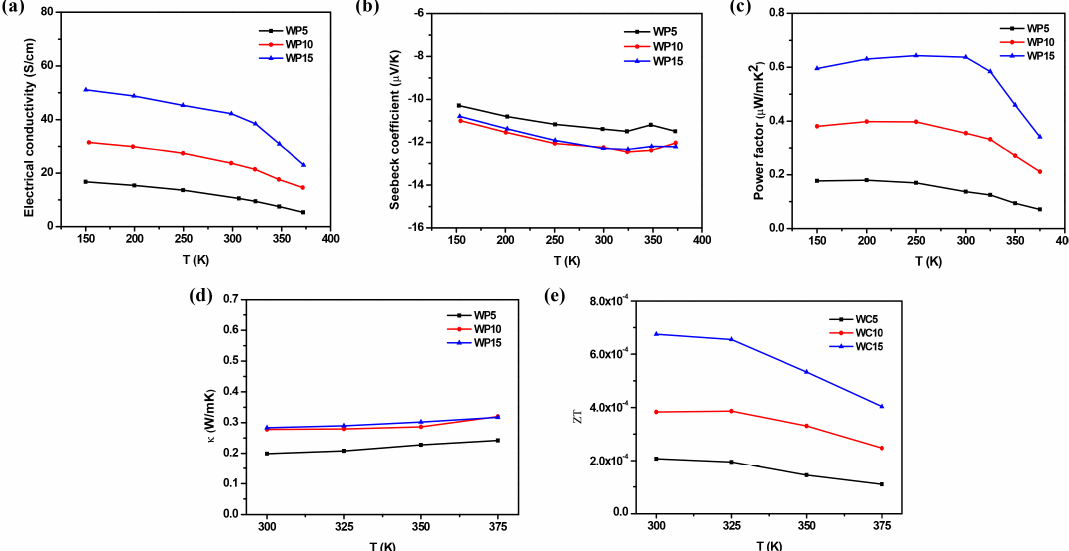
Figure 3. Electrical conductivity ( a ), Seebeck coefficient ( b ), calculated power factor ( c ), thermal conductivity ( d ), and ZT ( e ) of the WC/PLA thermoelectric composites. The Seebeck coefficients of all the composites are negative, indicating n ‐ type conduction.